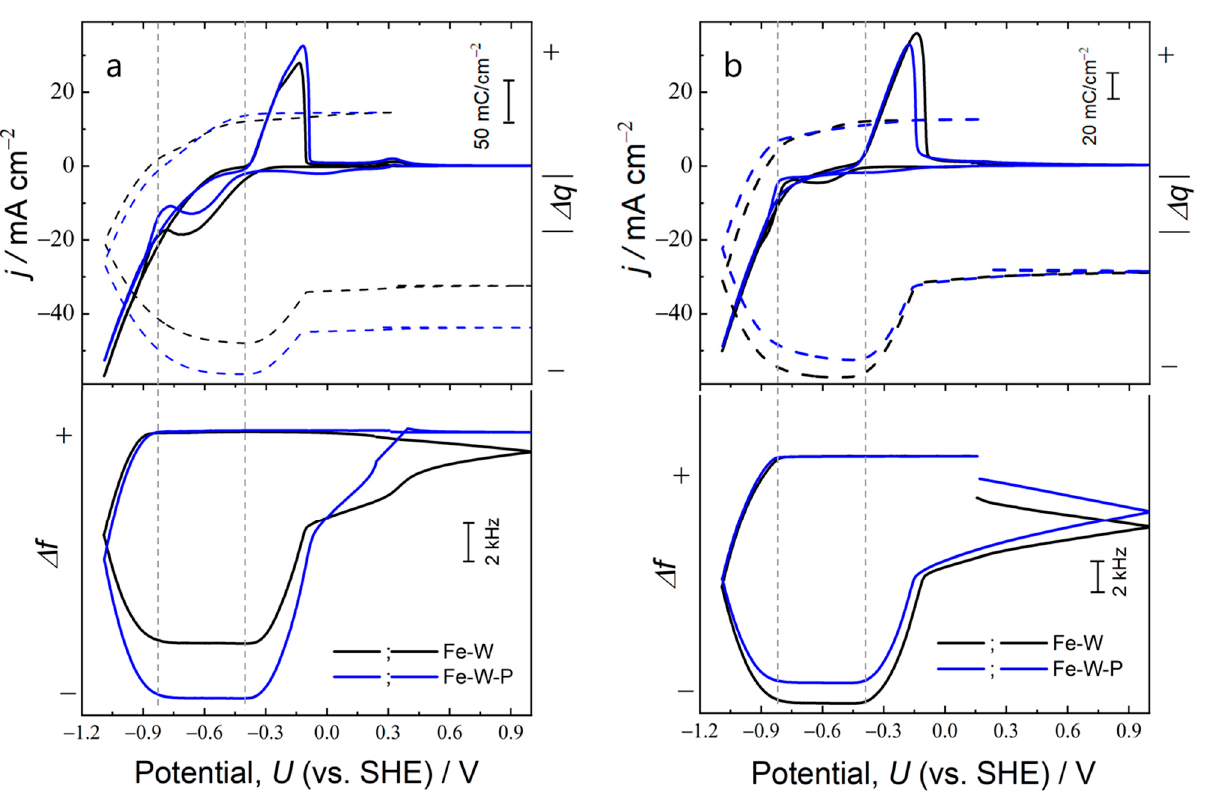
Figure 1. Electrochemical quartz microbalance data of the Fe-W and Fe-W-P electrodeposition (third potential cycle): current and charge density, and frequency change. ( a ) pH 3 and ( b ) pH 4.